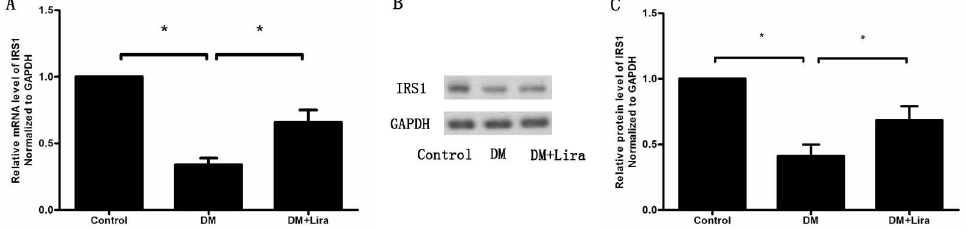
Fig 10. mRNA and protein levels of IRS1 in pancreatic tissues were measuredby qRT-PCR (A) and Western Blot (B and C). Diabeticrats were dividedinto two groups, administered without (DM group) or with liraglutide(DM + Lira group) at a dose of 200 μ g/kg/d. SD rats of control group were fed with normal